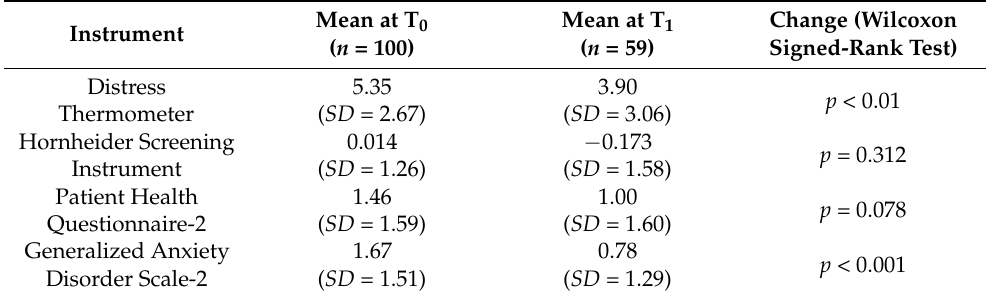
Table 4. Descriptive statistics regarding distress, psychosocial support, anxiety, and depression at T 0 and T 1